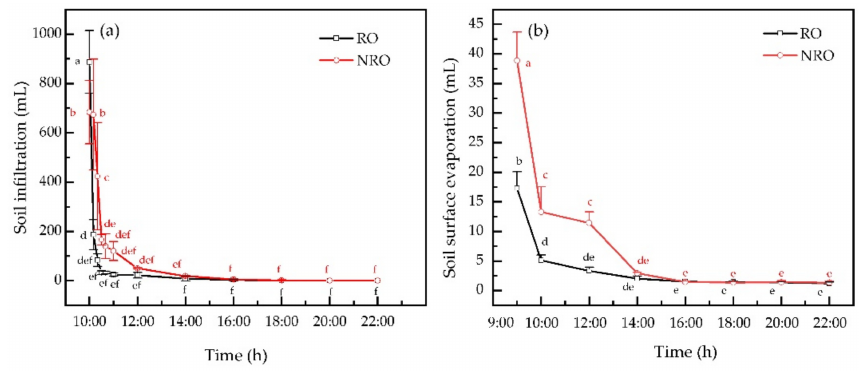
Figure 2. Diurnal variation in soil evaporation and infiltration in two habitats. ( a ) Changes in soil infiltration over time in two habitats. ( b ) Changes in soil evaporation over time in two habitats. RO and NRO represent rock outcrops and non-outcrops,